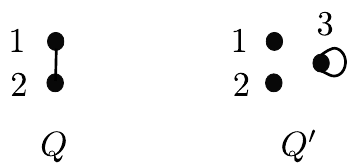
Figure 3. The quivers Q and Q 0 related by